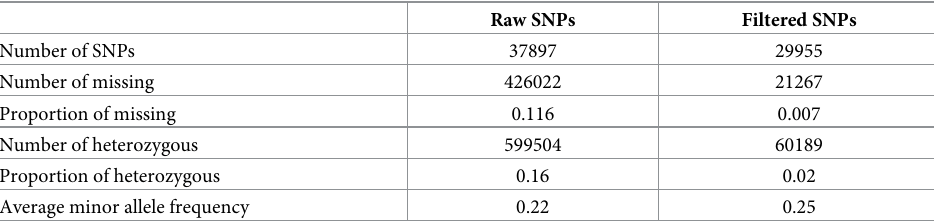
Table 2. SNP calling and filtering